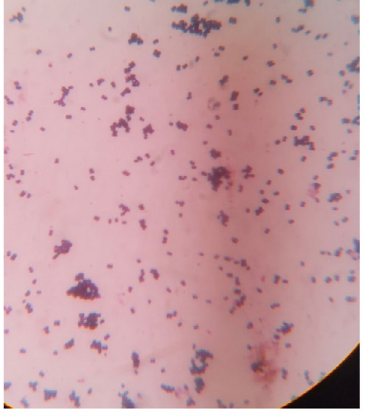
Fig. 1. Gram-stained smear from the growth showing Gram Positive cocci